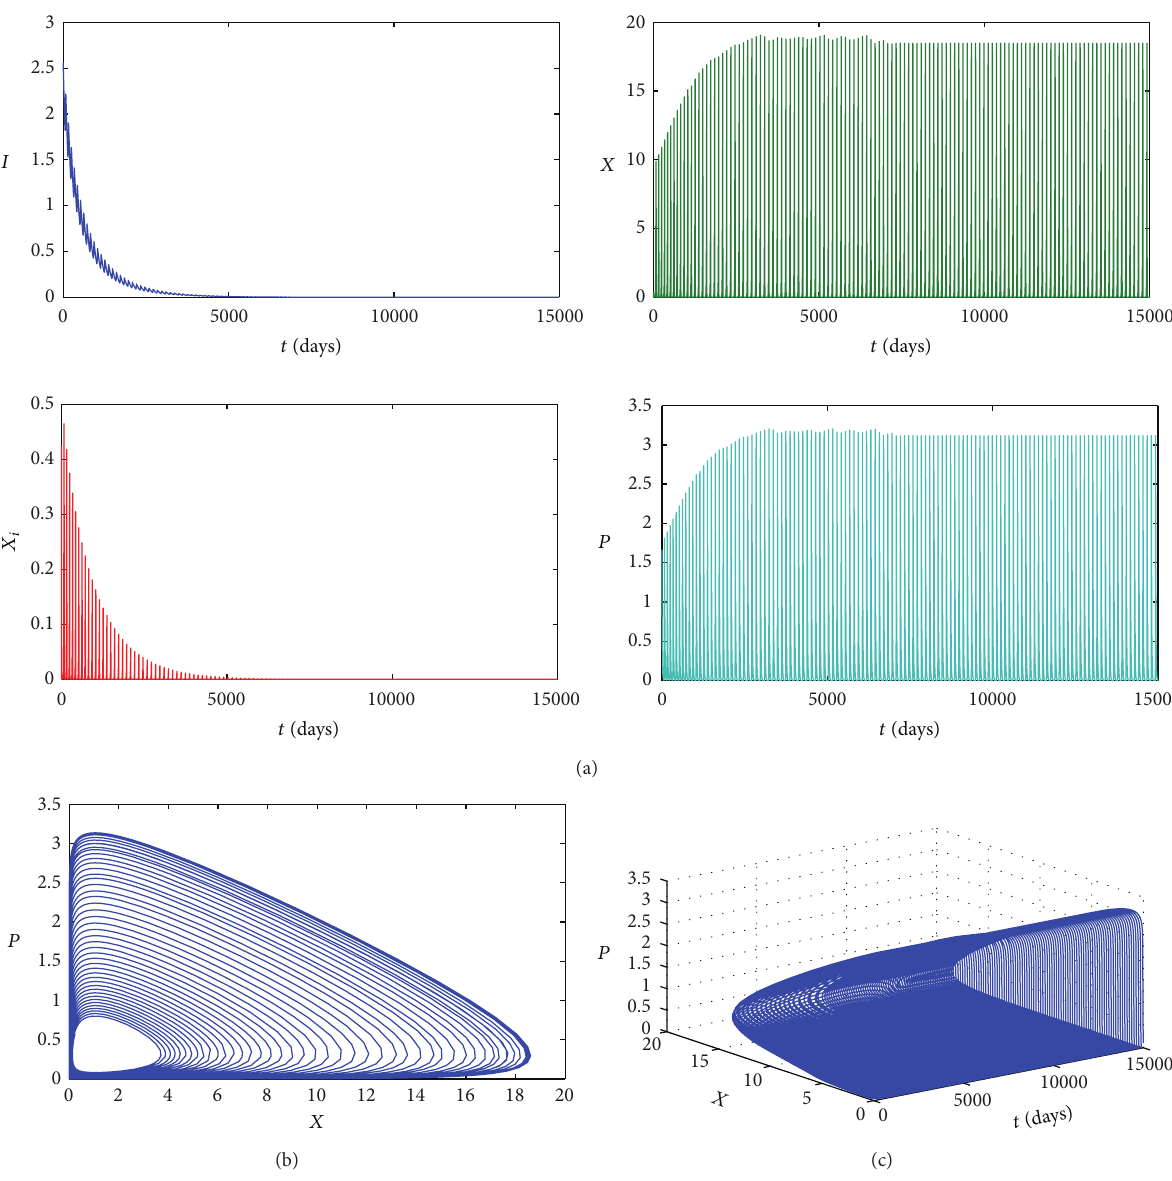
Figure 4: Numerical simulation for Case 2, with 𝑎 = 0.03 , ℎ = 0.65 , and other parameters fixed in Table 1. A stable limit cycle occurs in 𝑋𝑃 plane of system (2). (a) Temporal plots for system variables. (b) Phase portrait in 𝑋𝑃 plane. (c) Phase portrait in 𝑡𝑋𝑃